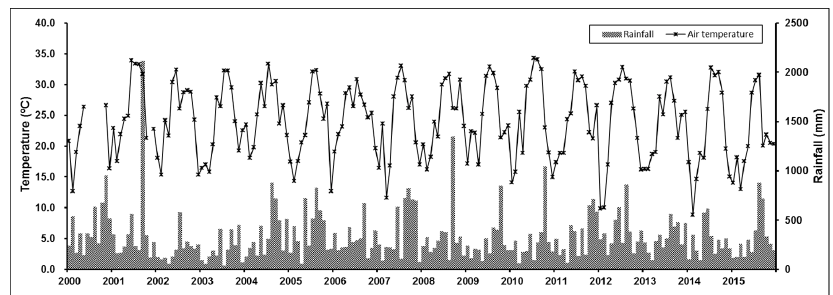
Figure 2. Time series of air temperature and rainfall in the Fei-Tsui Reservoir from 2000 to 2015.